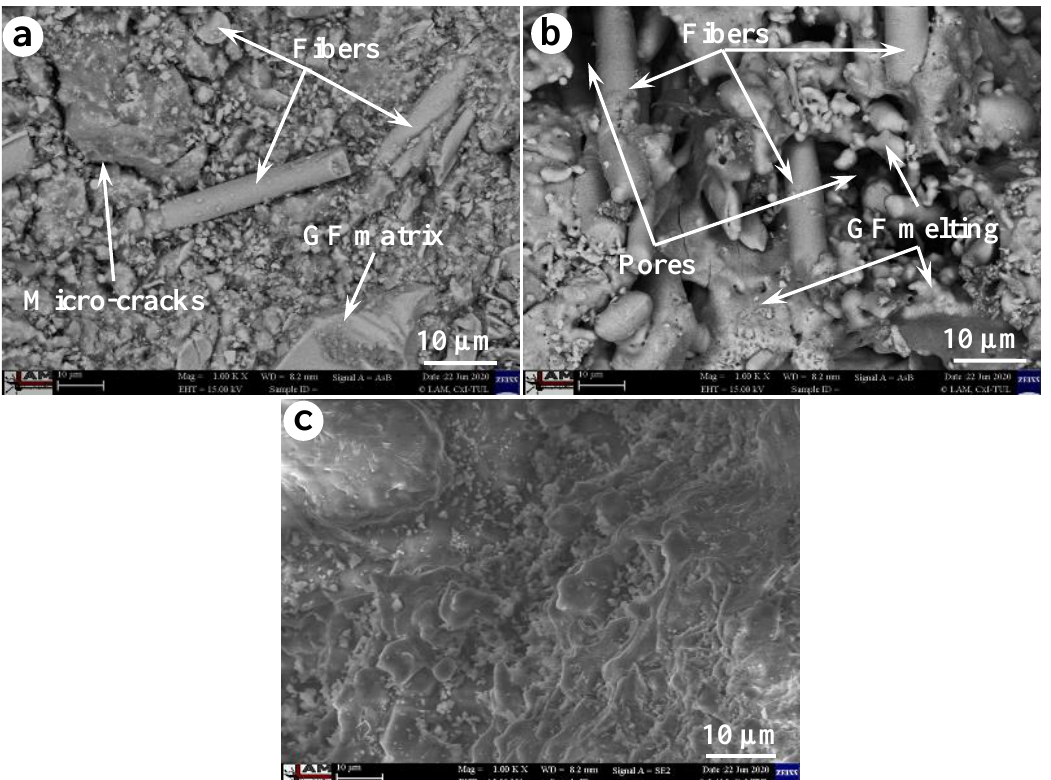
Figure 8. SEM micrographs of BGF samples type S3 at several specific temperatures: ( a ) room temperature (RT), ( b ) 1000, and ( c ) 1200 °C. Table 4. Chemical element composition of the sample S3 at different temperatures (wt.%).